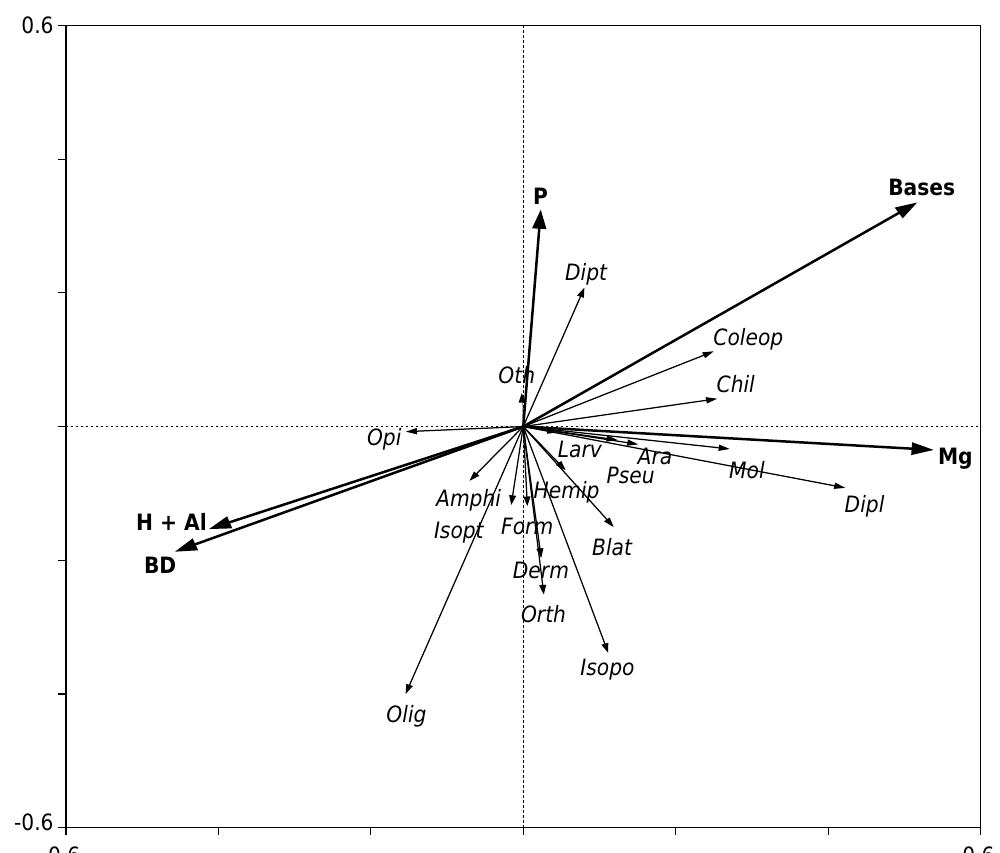
Figure 8. Redundancy analysis (RDA) for macrofaunal groups (in italics) and soil physical and chemical properties (in bold) in the winter sampling in the eastern region of Santa Catarina, Brazil. Oligochaeta ( Olig ), Formicidae ( Form ), Coleoptera ( Coleop ), Opiliones ( Opi ), Dermaptera ( Derm ), total of other larvae ( Larv ), Molusca ( Mol ), Pseudoscorpionidae ( Pseu ), Diplopoda ( Dipl ), Chilopoda ( Chil ), Isopoda ( Isopo ), Araneae ( Ara ), Blattodea ( Blat ), Isoptera ( Isopt ), Orthoptera ( Orth ), Amphipoda ( Amph ), Hemiptera ( Hemip ), Diptera ( Dipt ), and total of other less frequent groups ( Oth ). Chemical properties: phosphorus (P), magnesium (Mg), base saturation (Bases), potential acidity (H+Al), and physical properties: bulk density